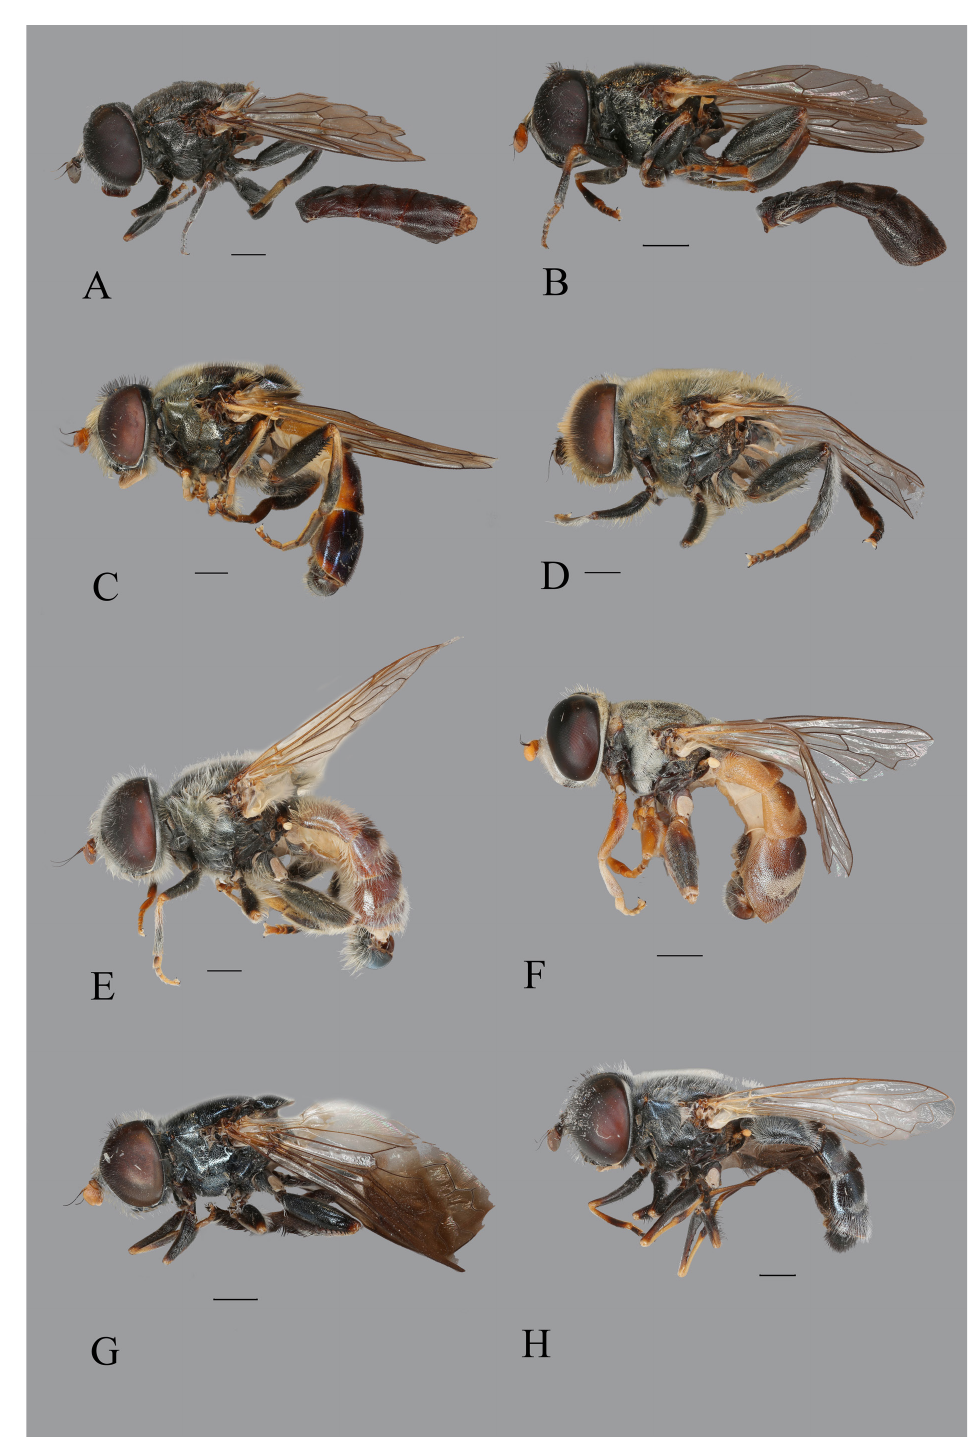
Fig. 6. Adult habitus, ♂, lateral view. A . Eumerus atricolorus Gilasian & van Steenis sp. nov., holotype (HMIM). B . E. brevipilosus Gilasian & van Steenis sp. nov., holotype (HMIM). C . E. falsus Becker, 1922, Chekab Valley, Iran (HMIM). D . E. chekabicus Gilasian & van Steenis sp. nov., holotype (HMIM). E . E. coeruleus (Becker, 1913), Chekab Valley, Iran (JSA). F . E. jacobsoni Becker, 1913, Chekab Valley, Iran (JSA). G . E. kazanovzkyae Paramonov, 1927, Paveh, Iran (HMIM). H . E. longitarsis Peck, 1979, Chekab Valley, Iran (JSA). Scale bars = 1.0